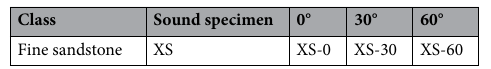
Table 1. Sample numbers of different rock types.